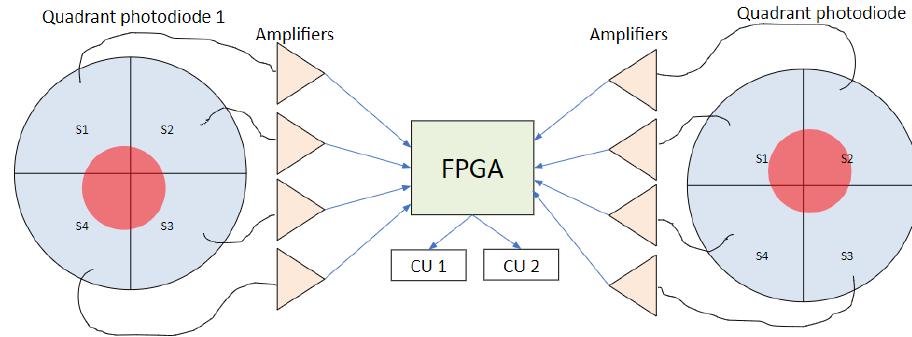
Figure 10. Beam position detection.